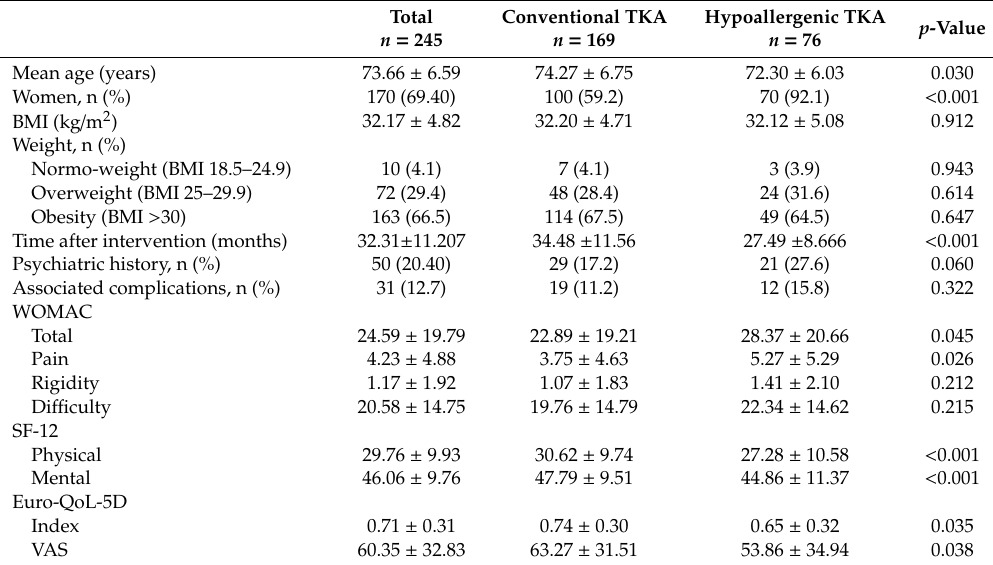
Table2. Descriptivecharacteristicsofthestudysample. Theresultsarepresentedasthemean ± standard deviation (SD) or total value and percentage. Body Mass Index (BMI), Western Ontario McMaster